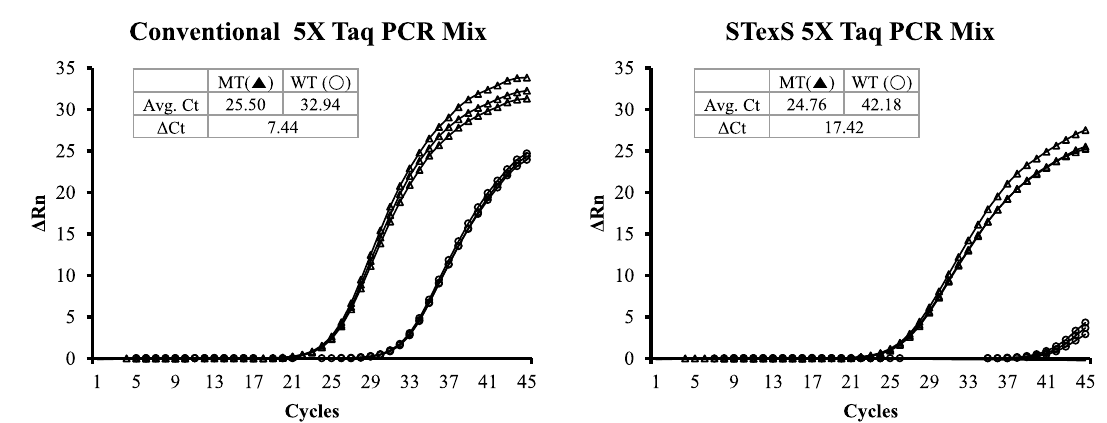
Figure 5. Amplification rates of conventional Taq PCR and STexS implemented Taq PCR. Each qPCR was performed using the conventional 5X Taq PCR mixture. The amplification ratio was calculated using the ΔΔCt value obtained by subtracting each Ct of the WT template and mutated template. qPCRs were performed with 790-F49-2 for EGFR T790M and 4 uM of AHP3 as dbOligo for STexS PCR was